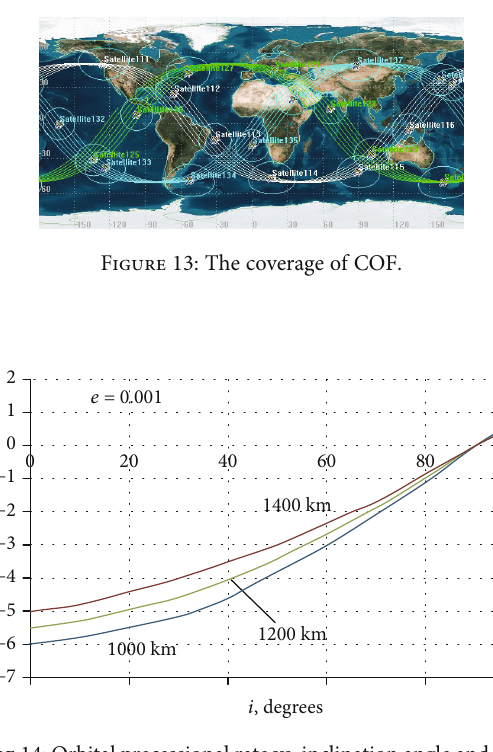
Figure 14: Orbital precessional rate vs. inclination angle and orbital altitudes to select the optimum set of parameters.